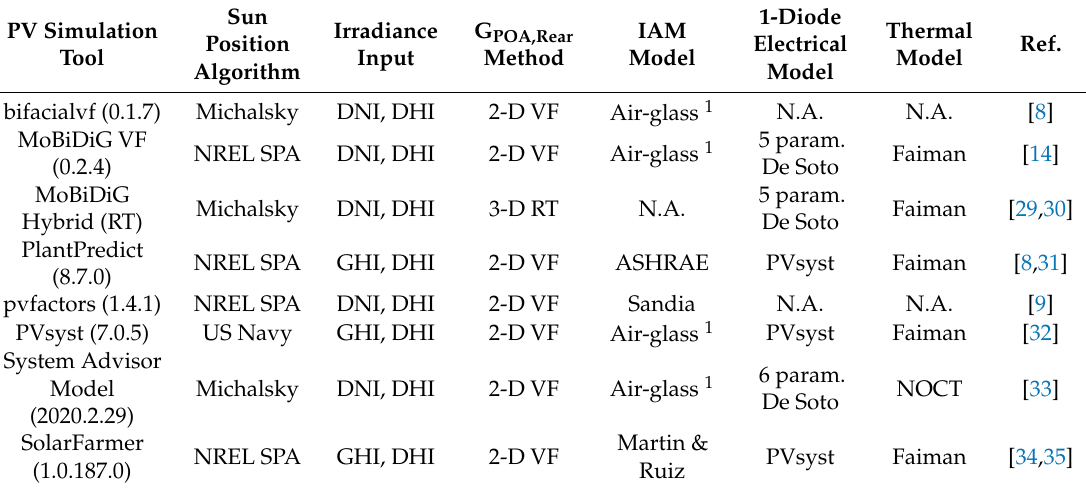
Table 1. Descriptions of the bifacial performance tools compared in this study. All tools implement the Perez transposition model for calculating global irradiance on the frontside plane of